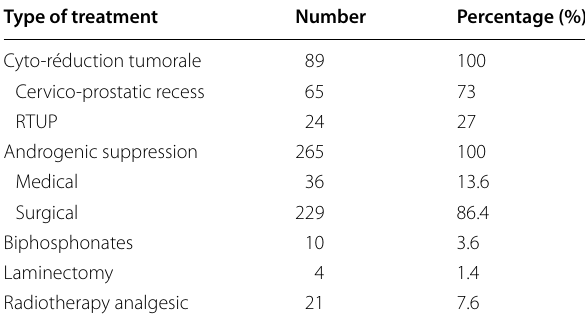
Table 4 Distribution of patients according to